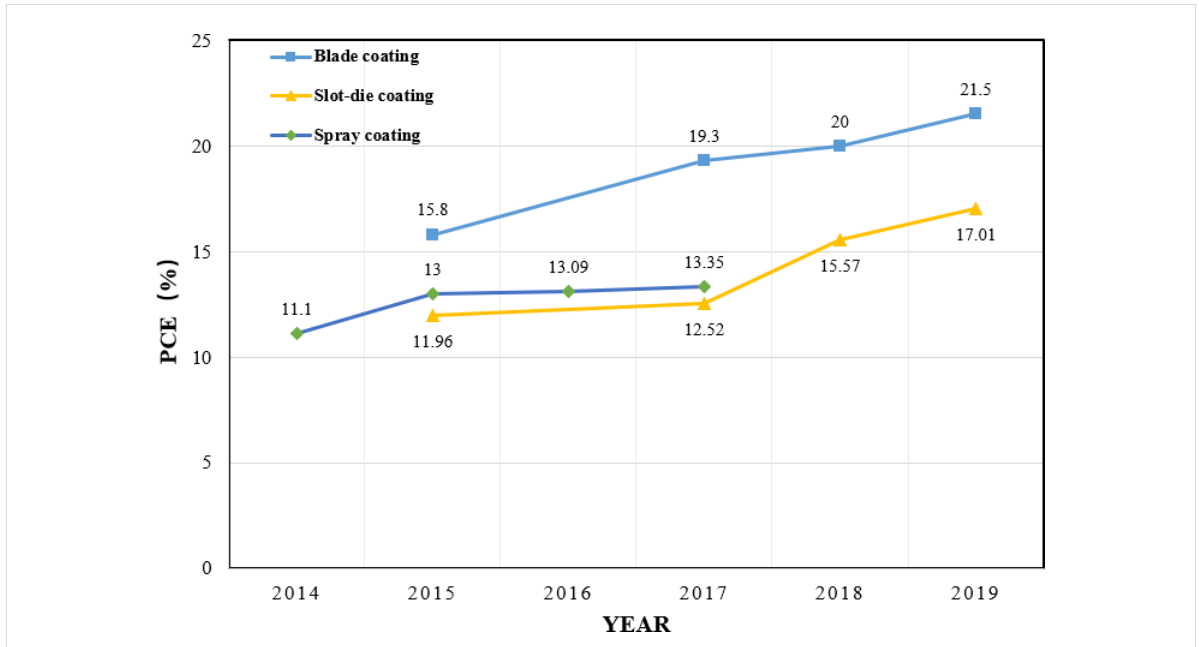
Figure 3: Progress of the efficiency of recently reported large-area PSCs fabricated by various deposition methods. The data is taken from [35-51].